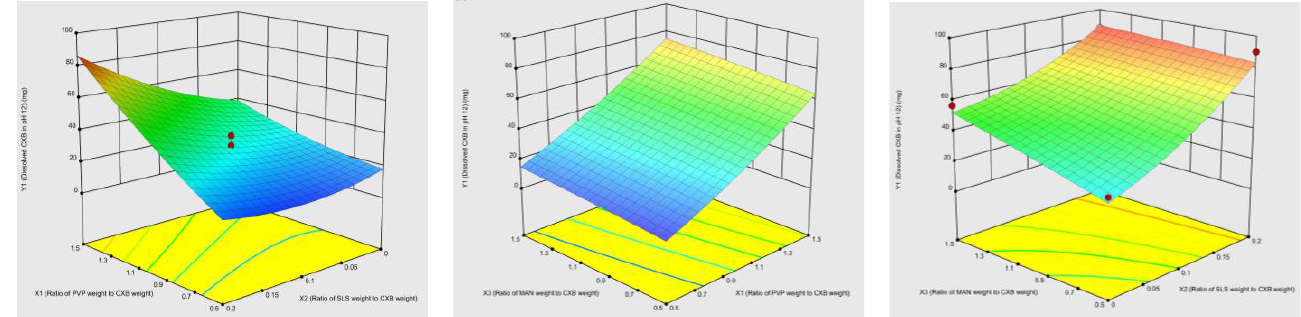
Figure 1. Three-dimension response surface showed the effects of PVP/CXB weight ratio (X 1 ), SLS/CXB weight ratio (X 2 ) and MAN/CXB weight ratio (X 3 ) on dissolved amount in pH 12 after 30 min (Y 1 ).